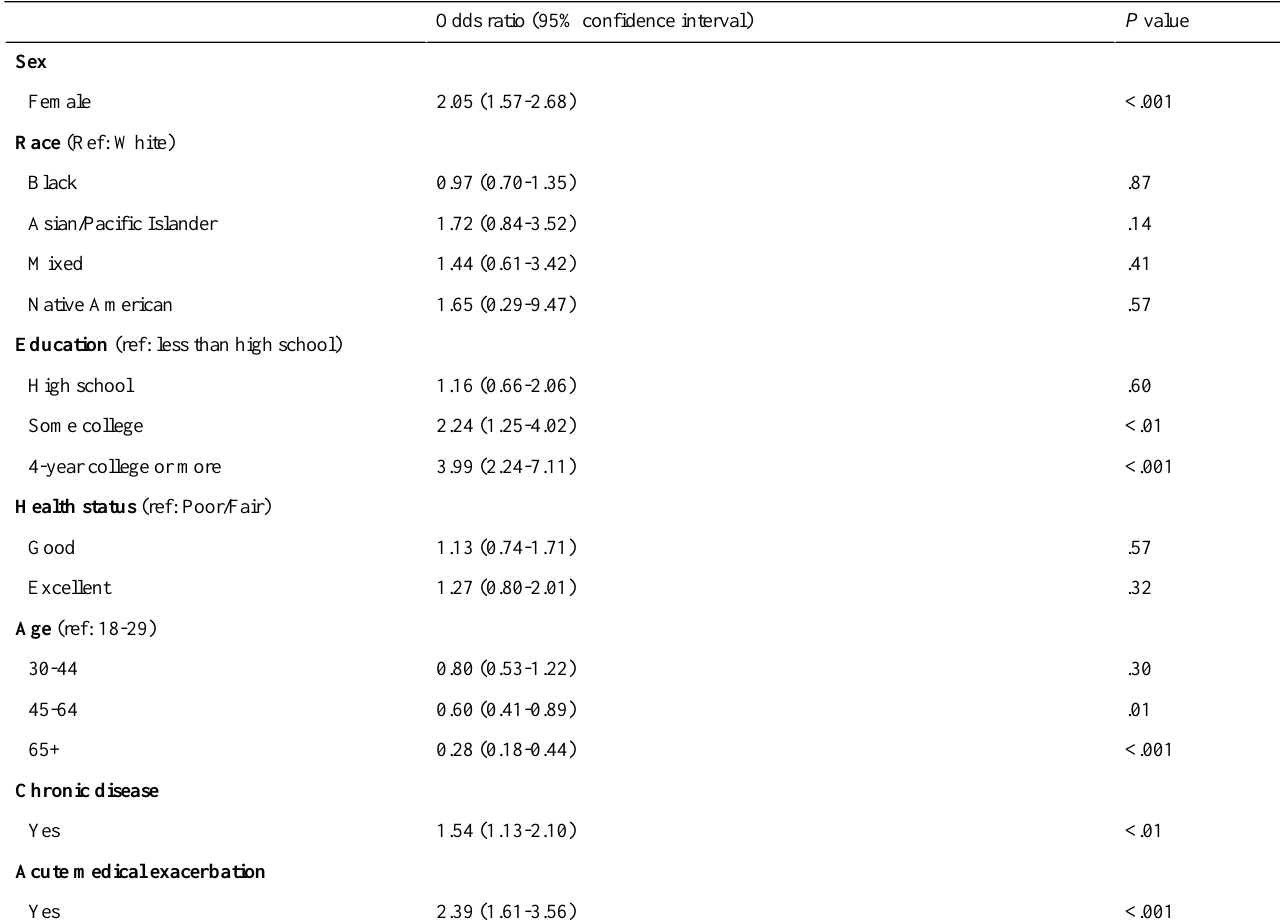
Table 2. Predictors of consuming any Web-based health